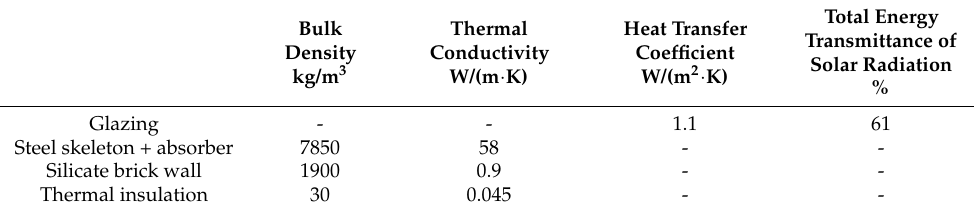
Table 1. Technical properties of the barrier’s components